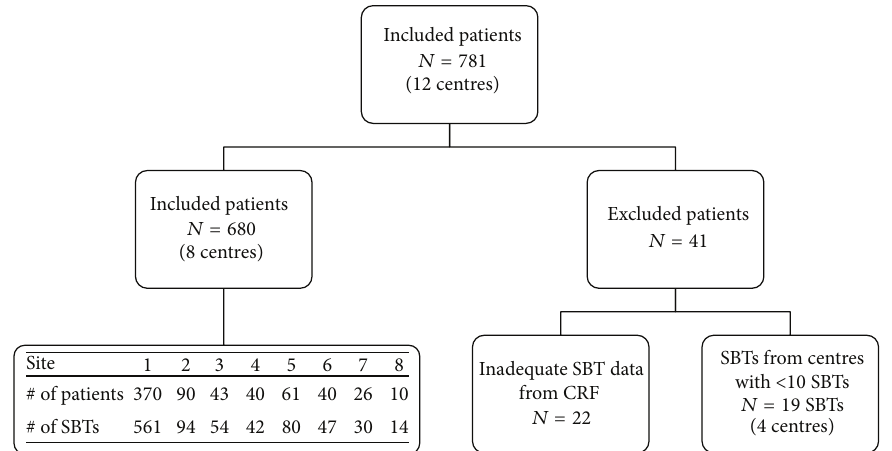
Figure 1: Flow diagram of selection of patients. The diagram shows how the dataset was reduced to ensure only spontaneous breathing trials (SBTs) with adequate case report form (CRF) data were included, and only sites with > 10 SBTs were compared for analysis. It includes a breakdown of number of patients and SBTs across sites. All SBTs from all patients enrolled in the Weaning and Variability Evaluation study were originally included.